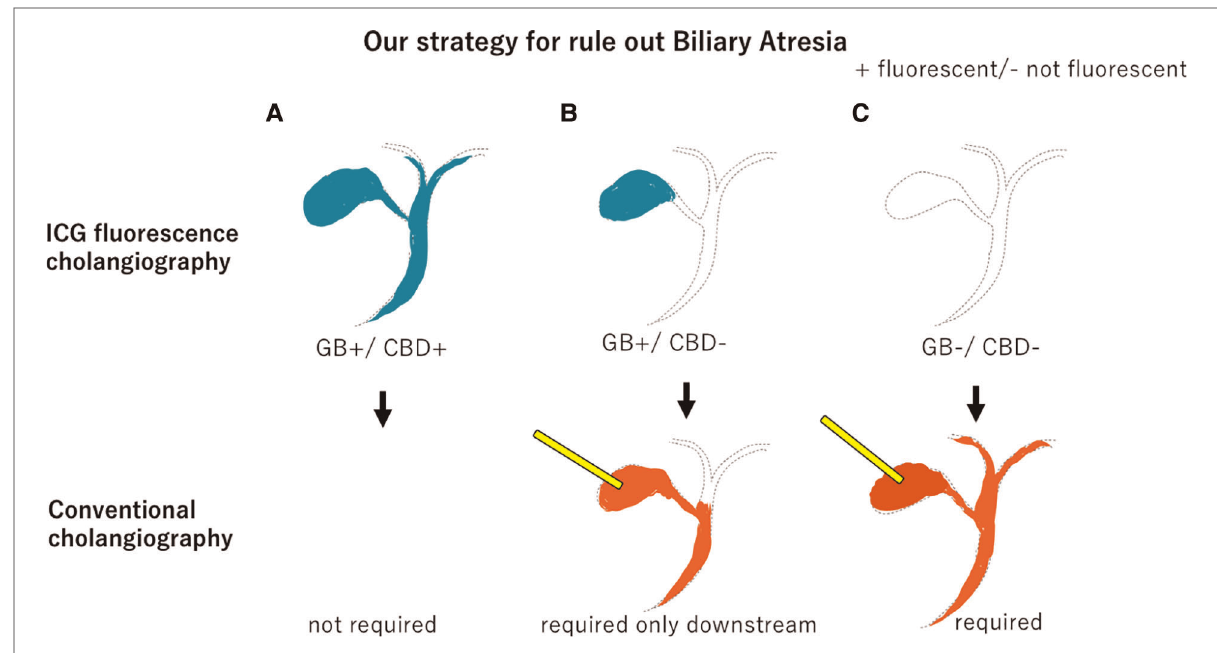
FIGURE 4 Our strategy to rule out Biliary Atresia. ( A ) If both the gallbladder and common bile duct fl uoresce on ICG fl uorescence cholangiography, conventional cholangiography is unnecessary. ( B ) If only the gallbladder fl uoresces, only downstream should be con fi rmed by conventional cholangiography. ( C ) If neither the gallbladder nor the common bile duct fl uoresces, both upstream and downstream should be con fi rmed by conventional cholangiography. GB,